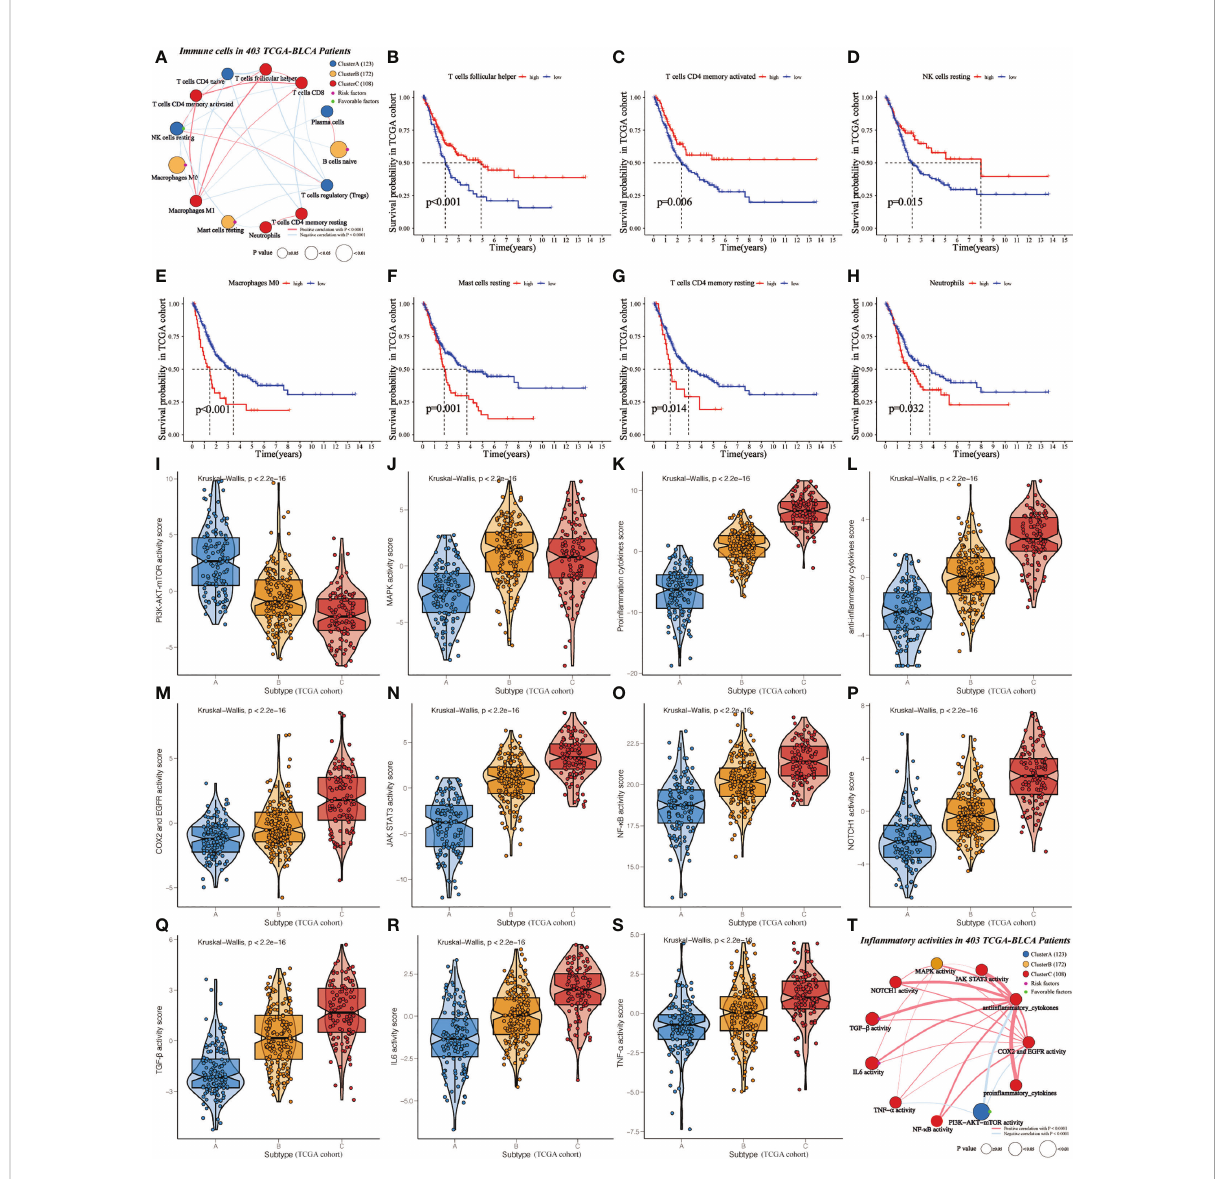
FIGURE 3 Identi fi cation of cluster-speci fi c and prognosis-related differentially expressed immune cells and in fl ammatory activities in TCGA-BLCA cohort. (A) Interaction of cluster-speci fi c and prognosis-related differentially expressed immune cells. Cluster A, blue; Cluster B, yellow; Cluster C, red. These circles highlighted in Green (purple) referred to favorable (risk) factors of overall survival. The size of each circle evaluated by Unicox p- values indicated the survival impact of each immune cell. The connection shows the interaction between two immune cells, and the thickness of the lines means the correlation strength among cells. The red (blue) lines represented the positive (negative) correlation. (B-H) KM curves were applied to estimate OS for the high- and low-level groups of differentially expressed immune cells. (I-S) The violin plots demonstrate the differences in expression levels of various in fl ammatory activities among clusters. (T) Interaction of cluster-speci fi c and prognosis-related differentially expressed in fl ammatory